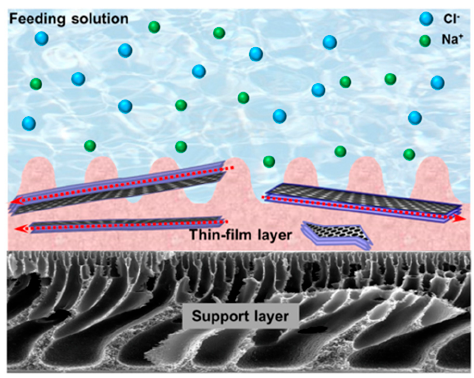
Figure 2. Schematic illustration of the hypothesized mechanism of graphene oxide (GO)